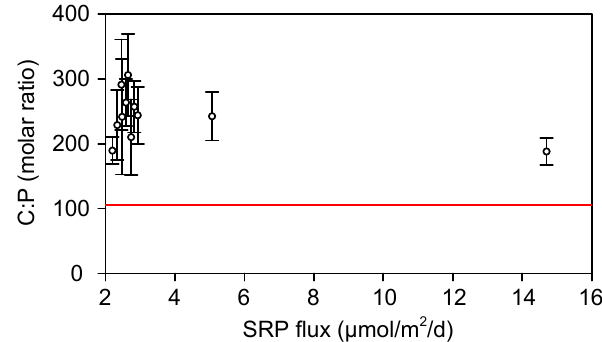
Fig. 7. C:P molar ratio as a function of vertical flux of SRP across the BV47 transect (see Fig. 1). Points represent geometric means ± SE. Red line represents Redfield C:P ratio (106). No sig- nificant relationship was detected between the C:P ratio and SRP supply